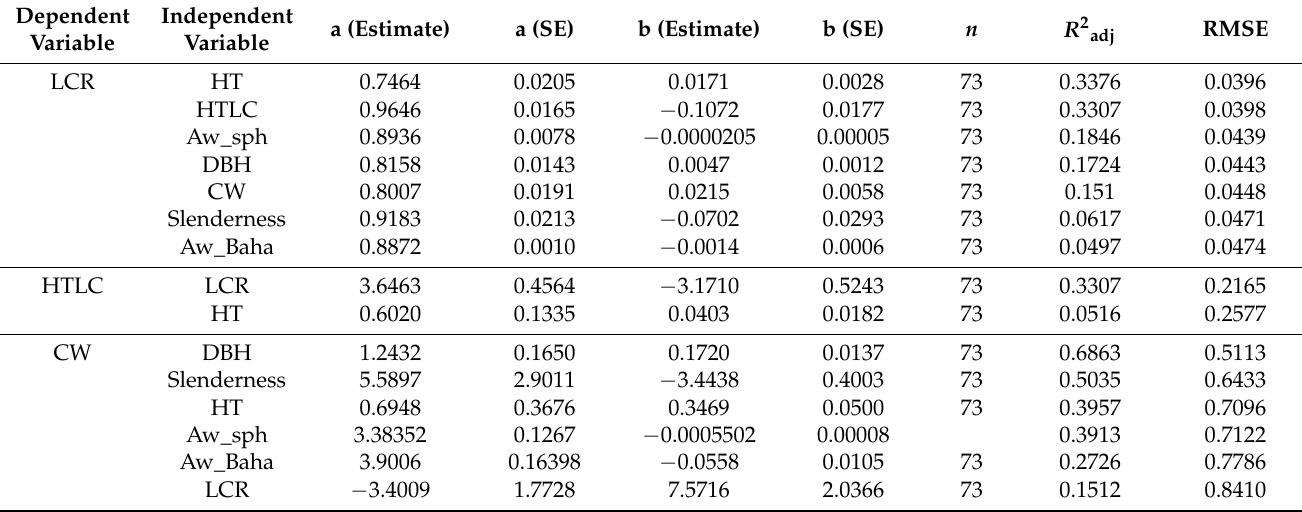
Table 7. Simple linear regression models for estimating crown characteristics for the sampled spruce. Model Y = a + bx. (HT= height (m); HTLC=height to the base of the live crown (m); Aw_sph = aspen stems ha − 1 (stems ha − 1 ); DBH = diameter at breast height (cm); CW = Crown width (m); LCR= live crown ratio (LCR = (HT-HTLC)/HT); Slenderness = HT/DBH;